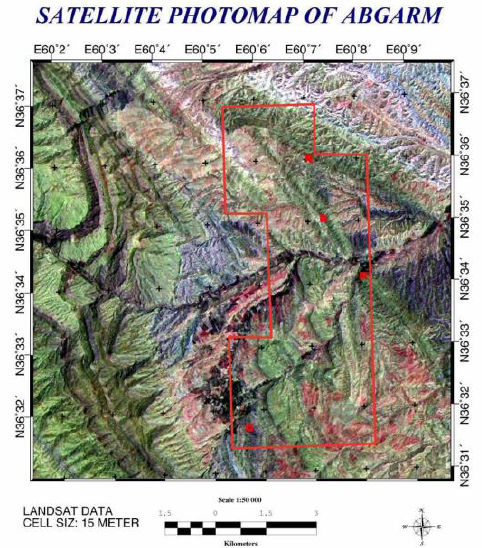
Figure 3. Landsat ETM+ color image RGB: 371, Glauconite units are in green color and check points are